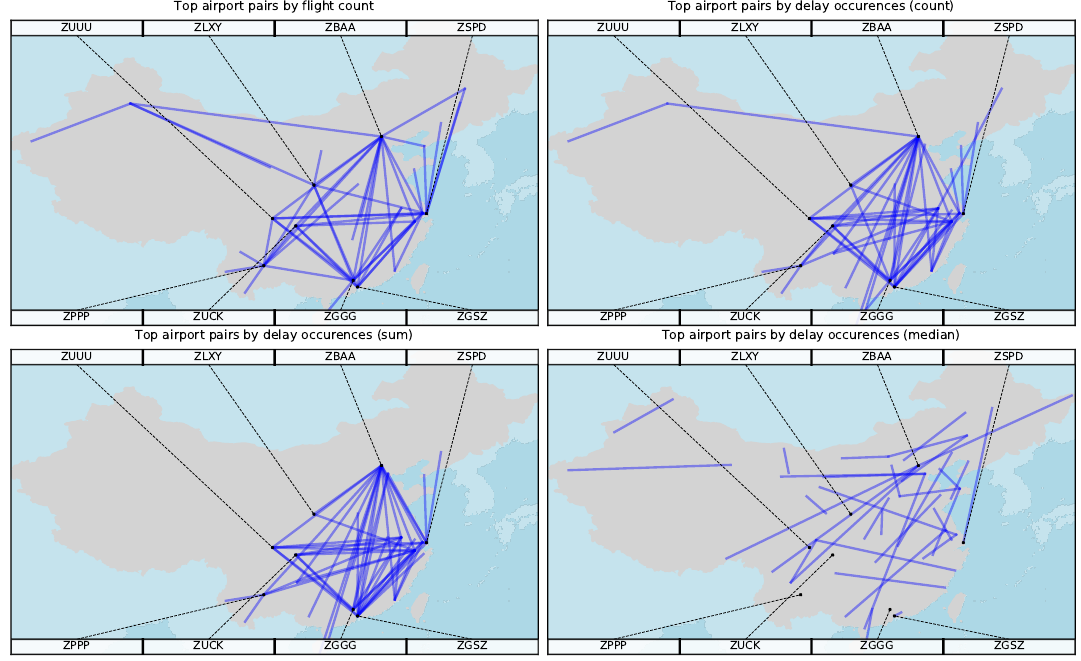
Figure 2. Highlighting of the top-ranked airport pairs in the data set according to different criteria: Largest number of flights (upper left), largest number of delayed flights (upper right), largest sum of delays (lower left) and largest median of delays (lower